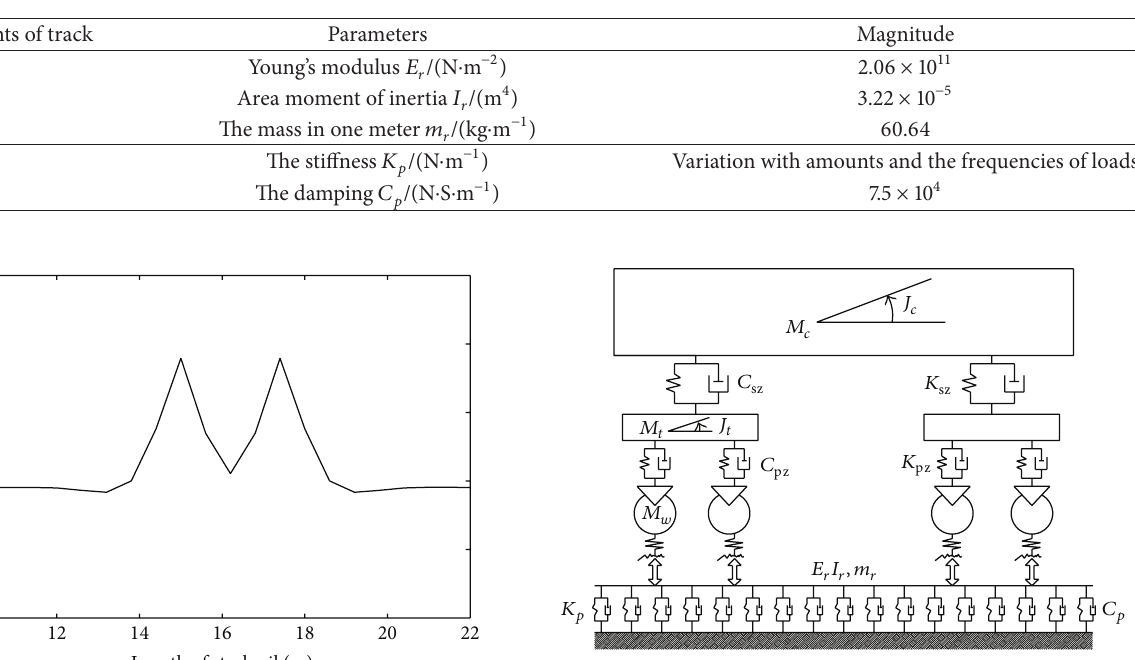
Table 2: The parameters of the monolithic nonballasted track.